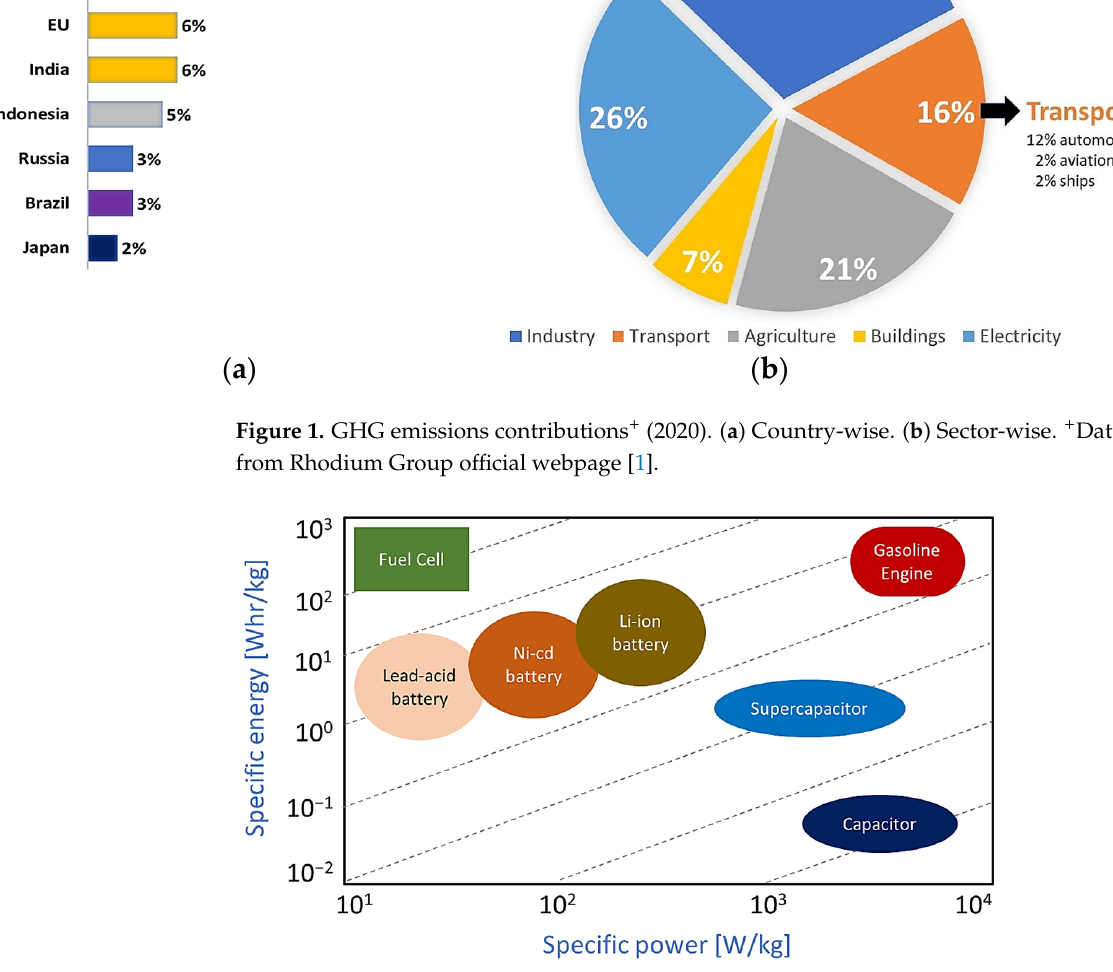
Figure 1. GHG emissions contributions + (2020). ( a ) Country-wise. ( b ) Sector-wise. + Data collected from Rhodium Group official webpage [1].